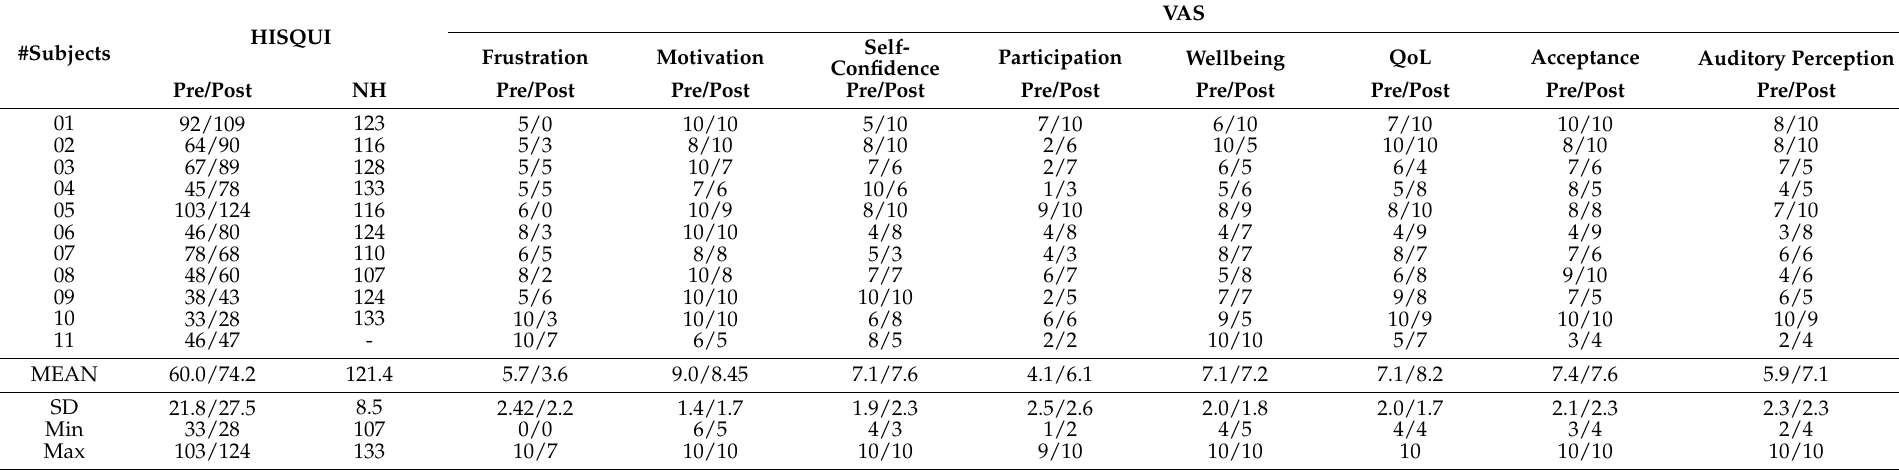
Table 3. Outcomes of the questionnaires HISQUI and VAS.